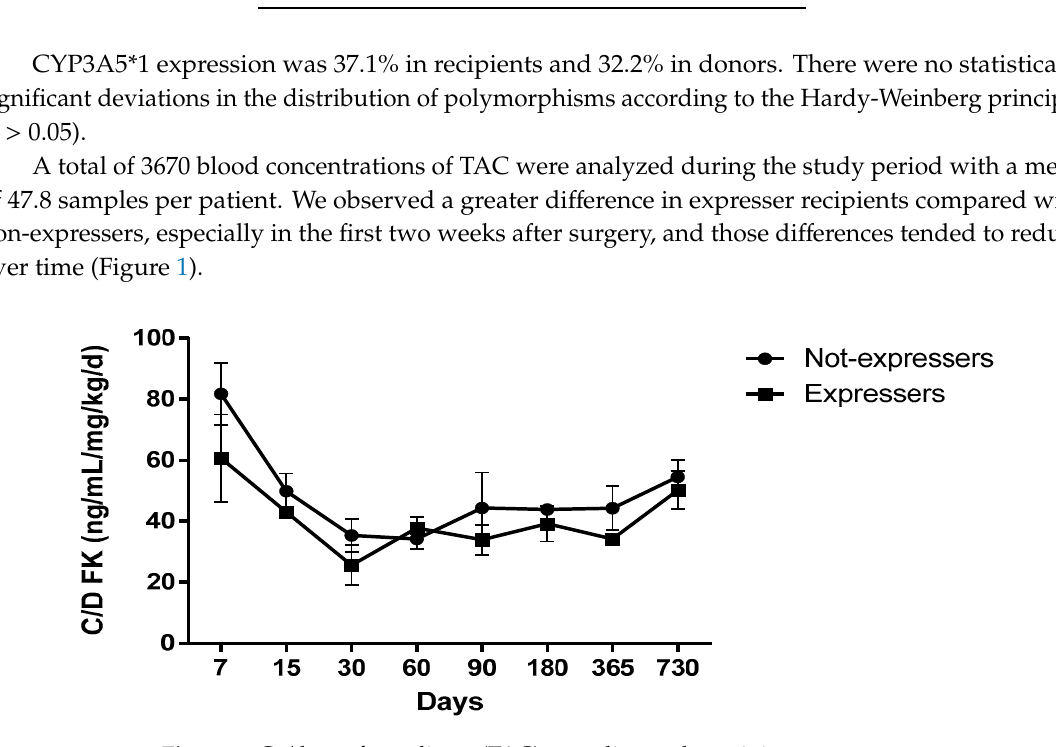
Figure 1. Co / dose of tacrolimus (TAC) according to the recipient Figure 1. Co/dose of tacrolimus (TAC) according to the recipient genotype.